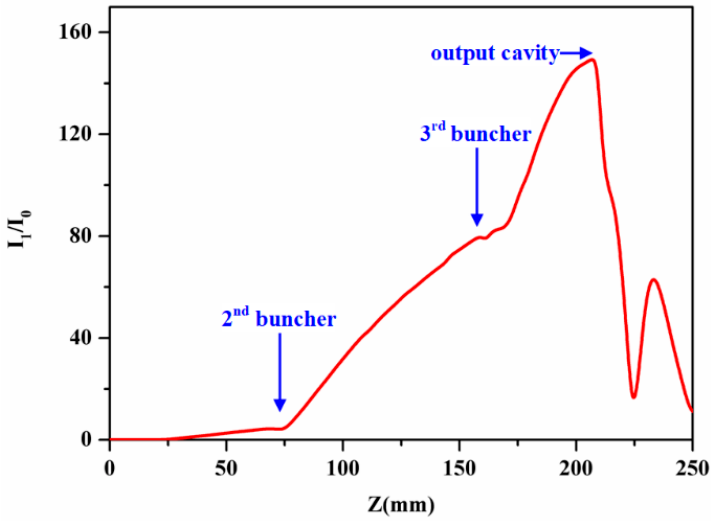
Figure 8. The first harmonic current with the deep modulation of a preliminary bunching signal, second and third bunching cavity.